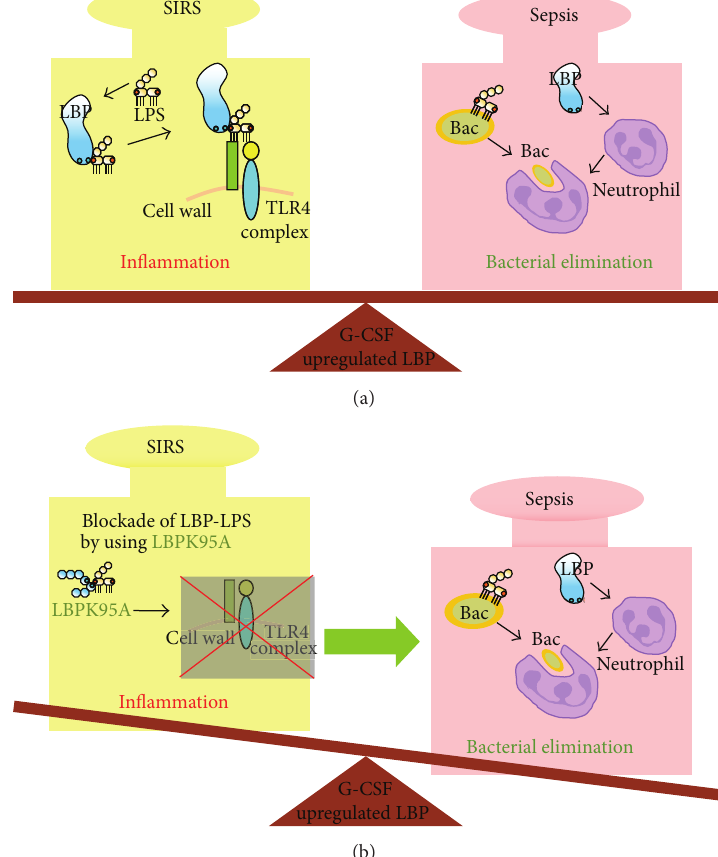
Figure 2: Balanced modulation of LBP-effect by LBP blockade and G-CSF pretreatment in sepsis. (a) on one hand, LBP promotes bacterial clearance, but on the other hand, it contributes to the sensitization of inflammatory response via activation of NF- 𝜅 B signaling pathway. (b) Interfering with the LBP-mediated inflammatory response by LBP blockade reduces the inflammatory injury and improves outcome after septic